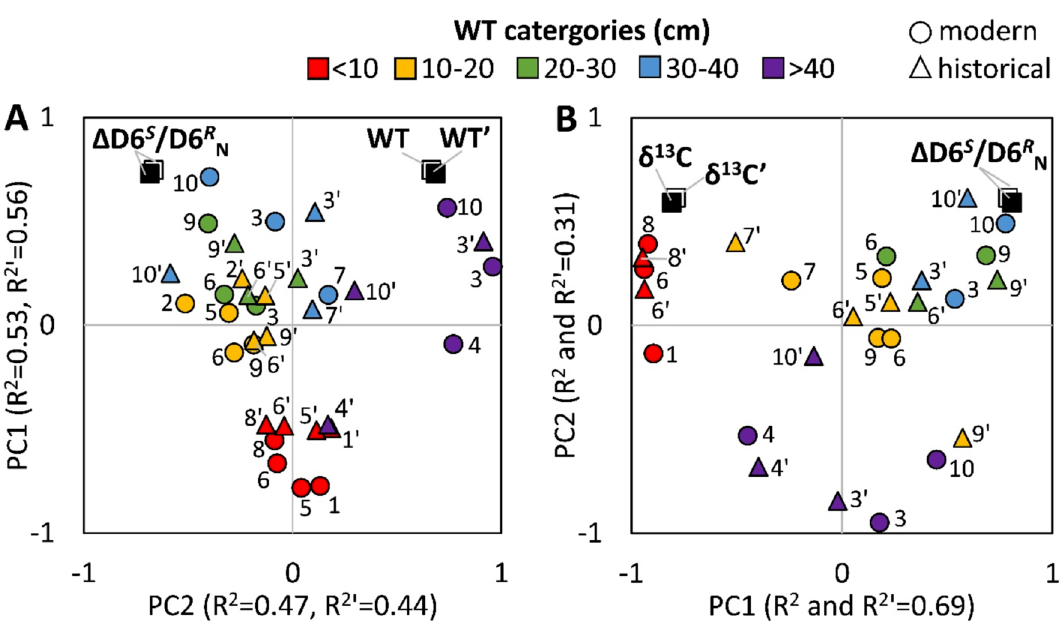
Figure 2. PCA biplots of the deuterium isotopomer ratio (ΔD6 S /D6 R N ) of Sphagnum during the twentieth century and ( A ) the modern water table depth (WT, circles) and the historical water table depth inferred from testate amoebae data from literature (WT ′ , triangles), and ( B ) modern Sphagnum -δ 13 C (δ 13 C) and historical δ 13 C data of ≥ 100 years-old Sphagnum samples (δ 13 C ′ ). Colour coding indicates WT categories. Numbers indicate respective sites in Fig. 1A. Apostrophe indicates historical data point. Note that in ( B ) δ 13 C data for